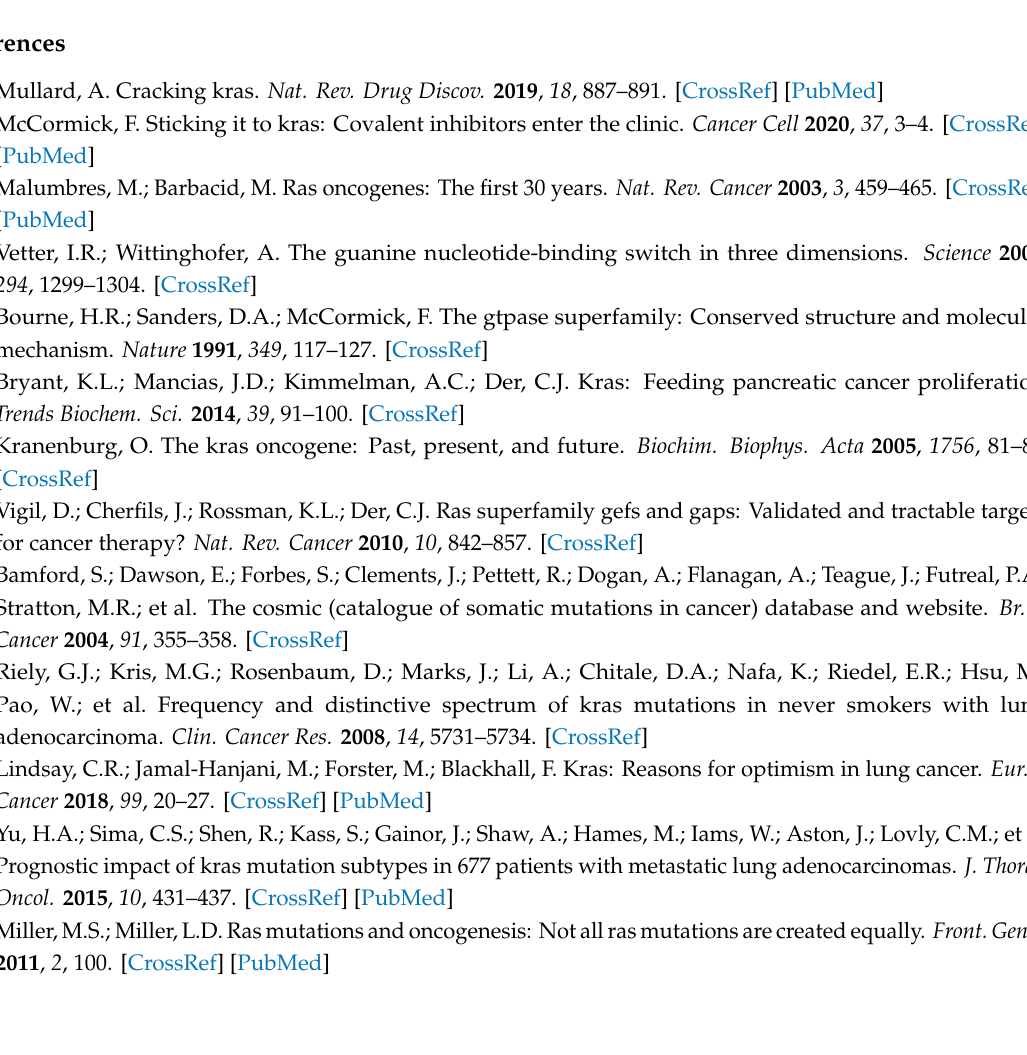
Figure S1: The mutation status of KRAS in H838 KRAS isogenic cells, Figure S2: The gene ontology and pathway analysis in H838 KRAS isogenic cells, Figure S3: The MAPK pathway in H838 KRAS isogenic cells, Figure S4: GEF-H1 was increased in H838 KRAS G12D cells. Figure S5: KRAS G12D inactivate the activity of WNT / β -catenin in MRC-5 cells. Figure S6: The RhoA suppress the expression of β -catenin in H838 KRAS isogenic cells. Figure S7: The mutation status of KRAS in KRAS-mutant NSCLC cells. Figure S8: The migration ability of KRAS G12V mutant NSCLC cells were attenuated by LGK974, Table S1: Quantitative real-time PCR primers used in this study, Table S2: List of antibodies used in western blotting, Figure S9: The uncropped blots and molecular weight markers of Figure 5, Figure S10: The uncropped blots and molecular weight markers of Figure